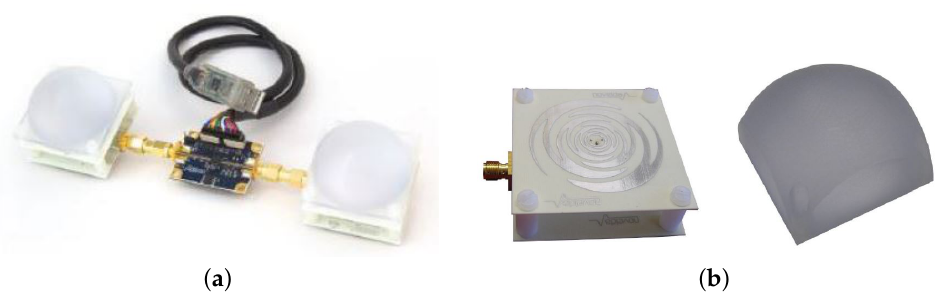
Figure 1. UWB-radar instrumentation. ( a ) Radar Novelda NVA-R661. ( b ) Sinuous antennas and dielectric